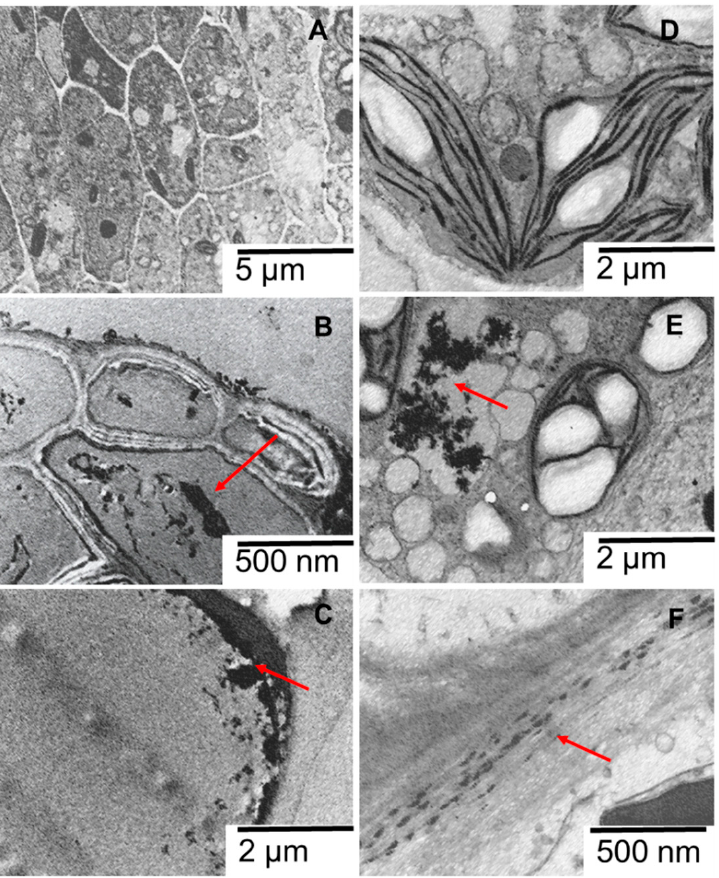
Figure 7. Cross-sectional images of the root ( A ) and frond ( F ) of control S. polyrhiza , and the root ( B , C ) and frond ( D , E ) of S. polyrhiza exposed to 100% ( v / v ) PR-ENMs of SUN1. The arrows indicate deposits suspected to be PR-ENMs.